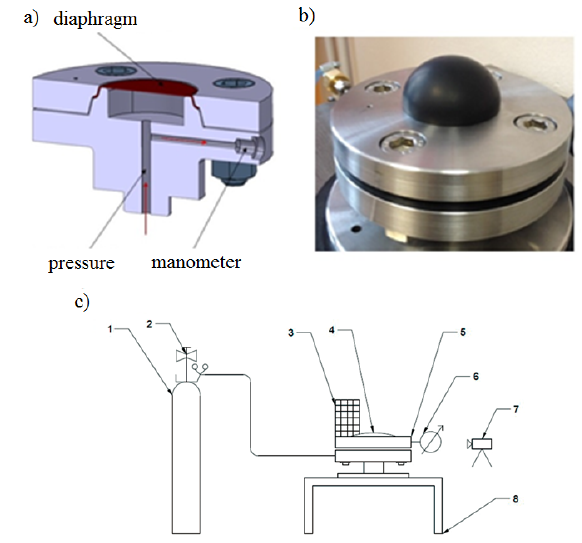
Figure 7: Test rig to biaxial stretch of rubber by means of bubble inflated method a) flange joint, b) view of inflated diaphragm, c) scheme of the test rig 1- reservoir, 2-regulating valve, 3-milimetric scale, 4- rubber sample, 5-flange joint, 6-manometer, 7-camera,